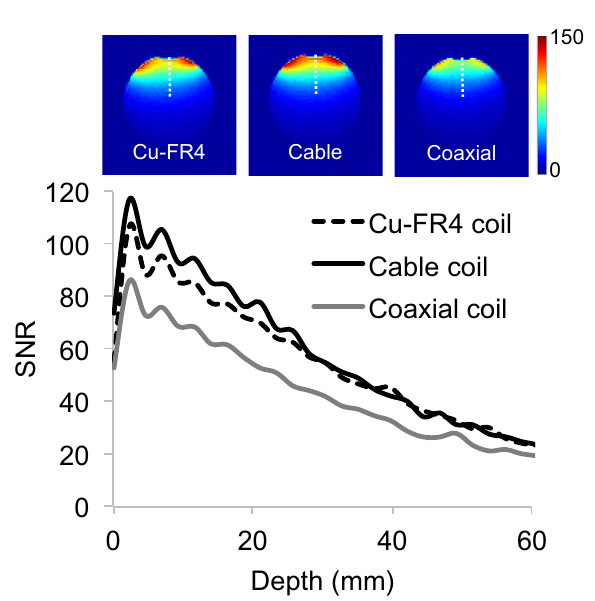
1 − Q ratio − 1 (cid:31)